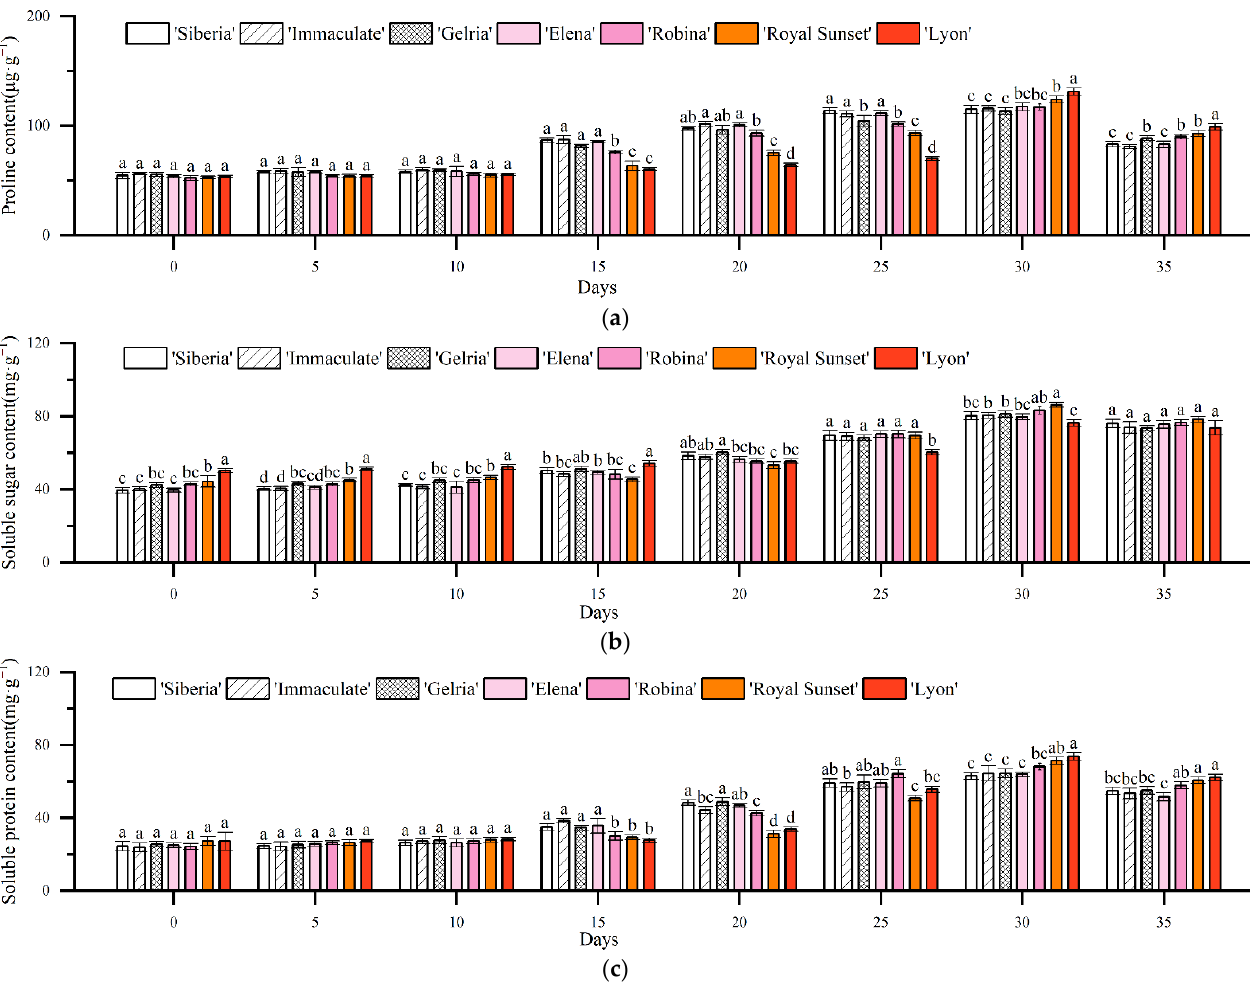
Figure 7. Effects of drought stress on the physiological metabolism of lily leaves: ( a ) Effects of drought stress on proline content; ( b ) Effects of drought stress on soluble sugar content; ( c ) Effects of drought stress on soluble protein content. Different letters above bar graphs indicate significant difference among lily varieties ( p < 0.05, n = 3).